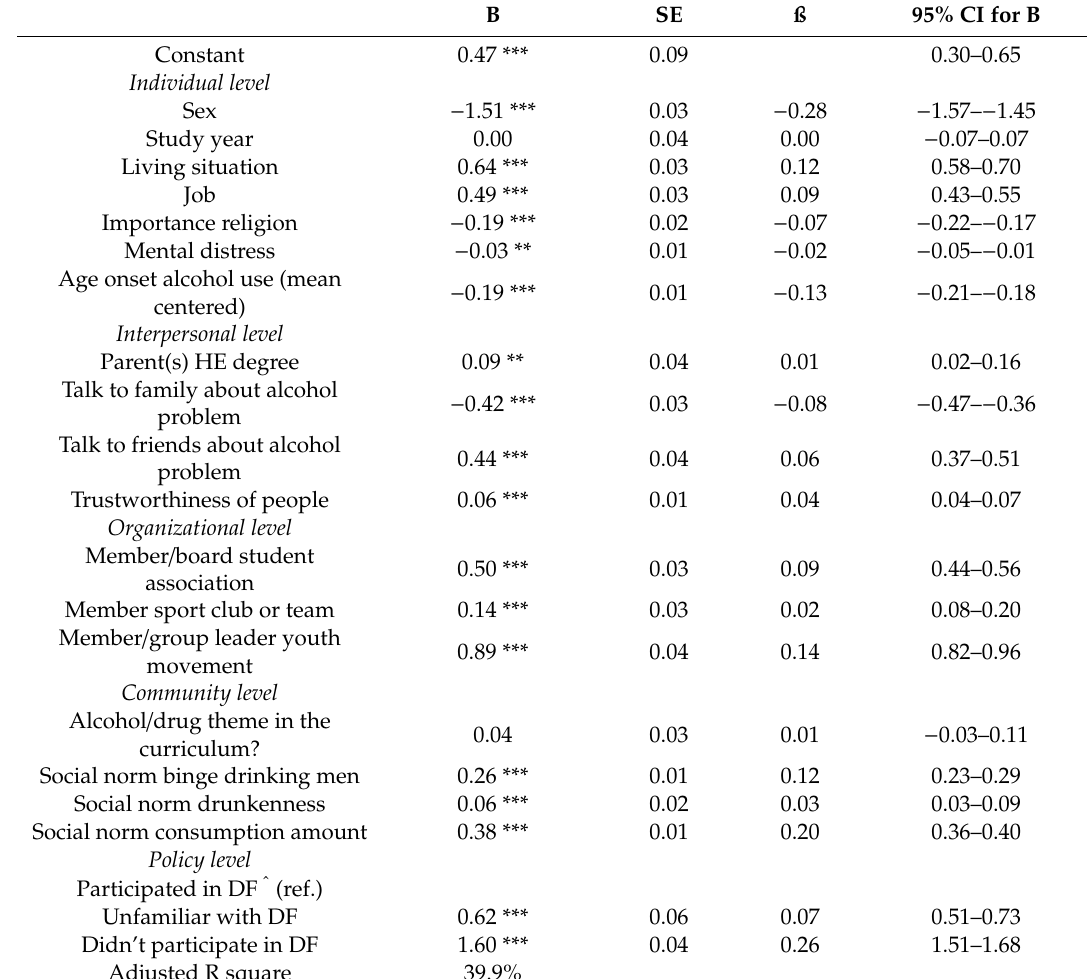
Table 3. Final multiple regression model predicting AUDIT-C ( n =